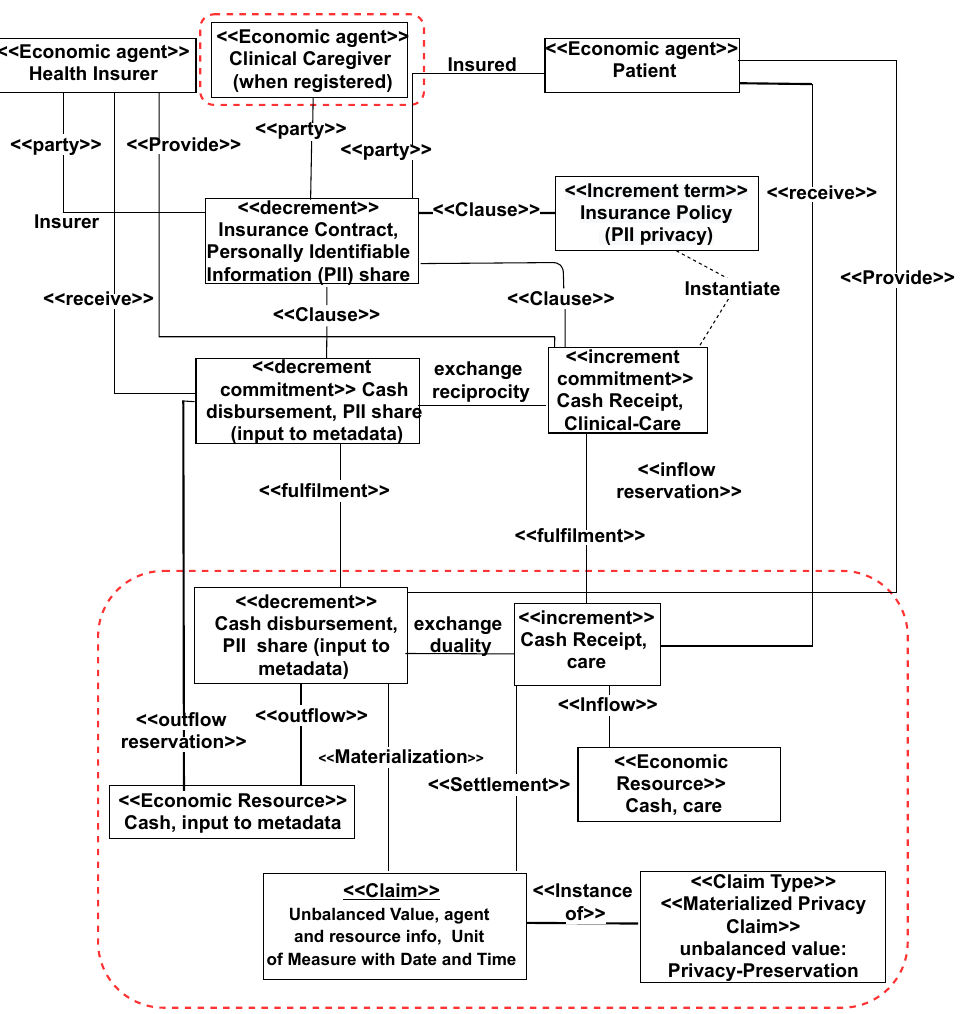
Figure 7. REA using Insurance Model and explicating privacy as a materialized